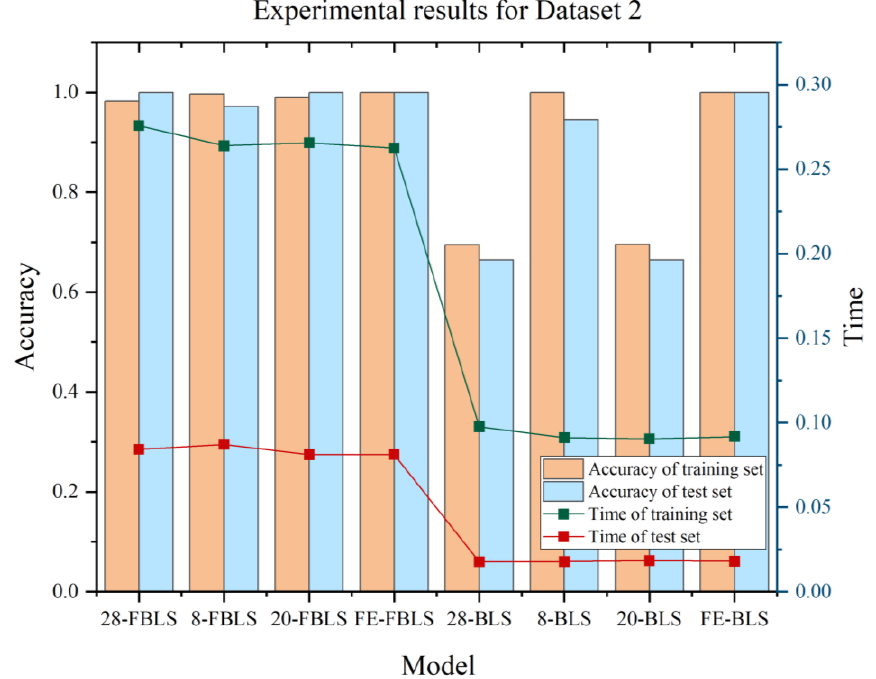
Figure 9. Experimental results of different features on dataset 2.